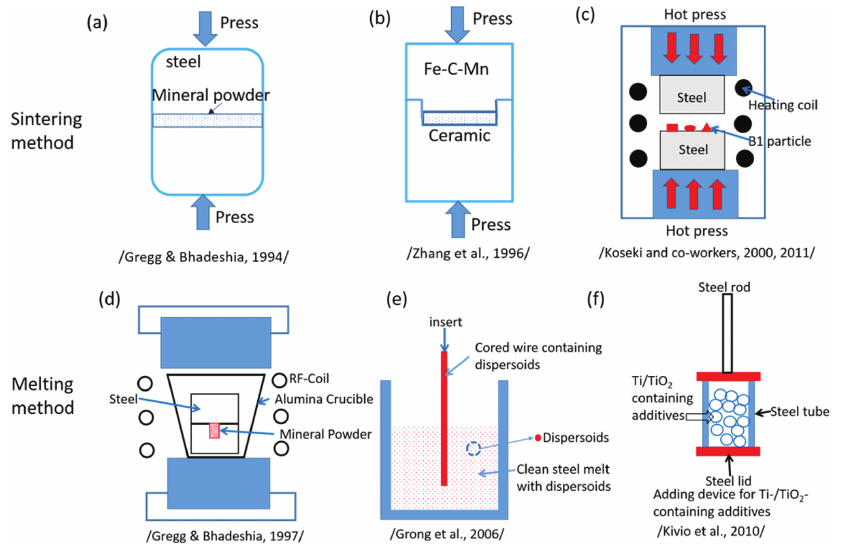
Figure 2: Schematic illustrations of dif- ferent methods to prepare steels with pure ceramic powders additions, revised by the original figures in Refs [17 – 23].